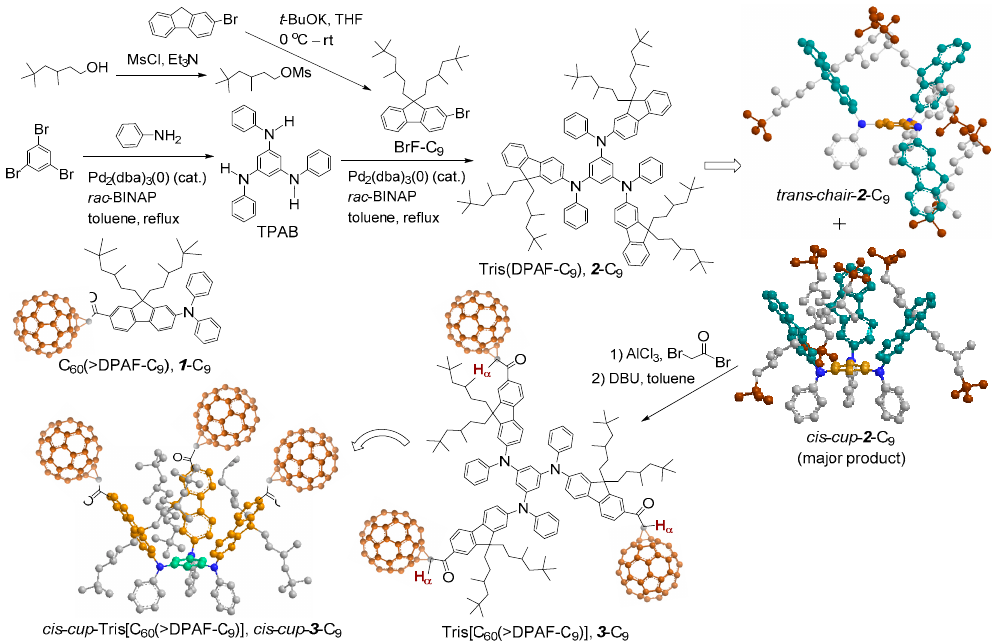
Figure 1. Synthetic route to the preparation of cis - cup -tris[C 60 (>DPAF-C 9 )] ( cis - cup - 3 -C 9 ) from the isolated precursor cis - cup -tris(DPAF-C 9 ) ( cis - cup - 2 -C 9 ) with reaction reagents